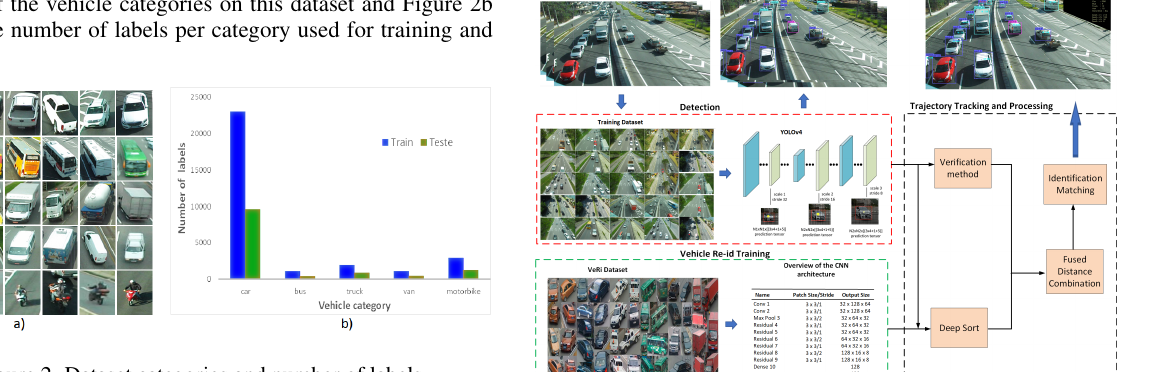
Figure 2. Dataset categories and number of labels.